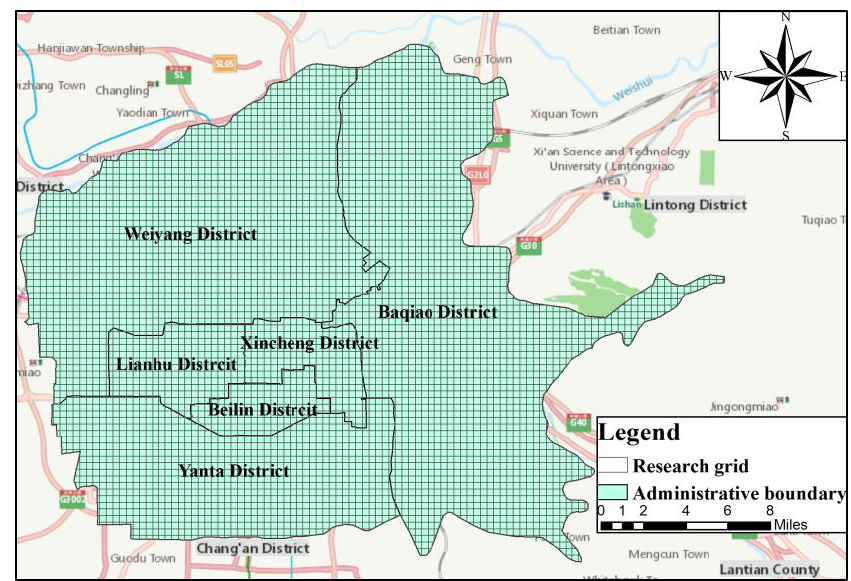
Figure 1. Study area and units.